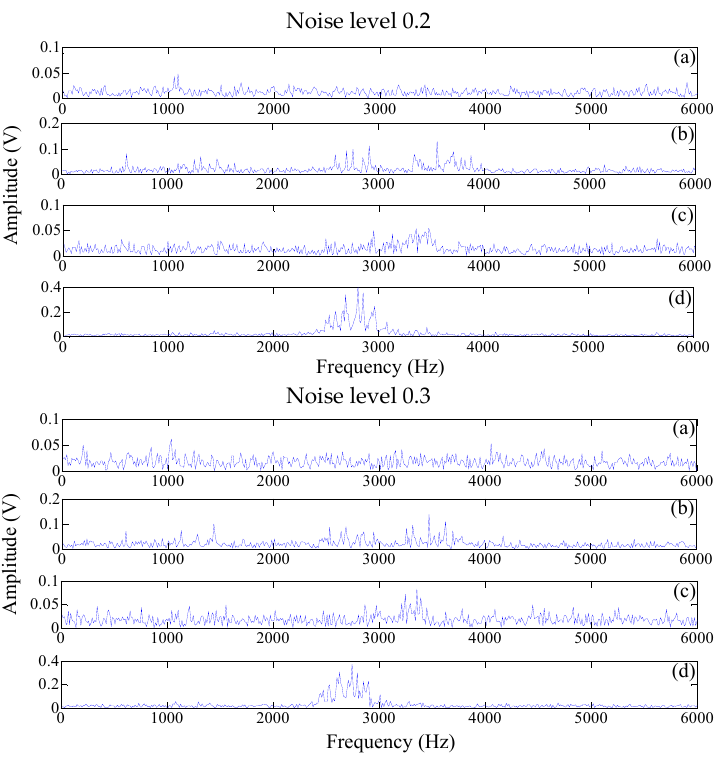
Figure 12. Examples of noised signals (from level 0.1 to 0.3) for each health condition ( a ) normal-bearing signal; ( b ) inner race fault-bearing signal; ( c ) ball fault-bearing signal; and ( d ) outer fault-bearing signal.